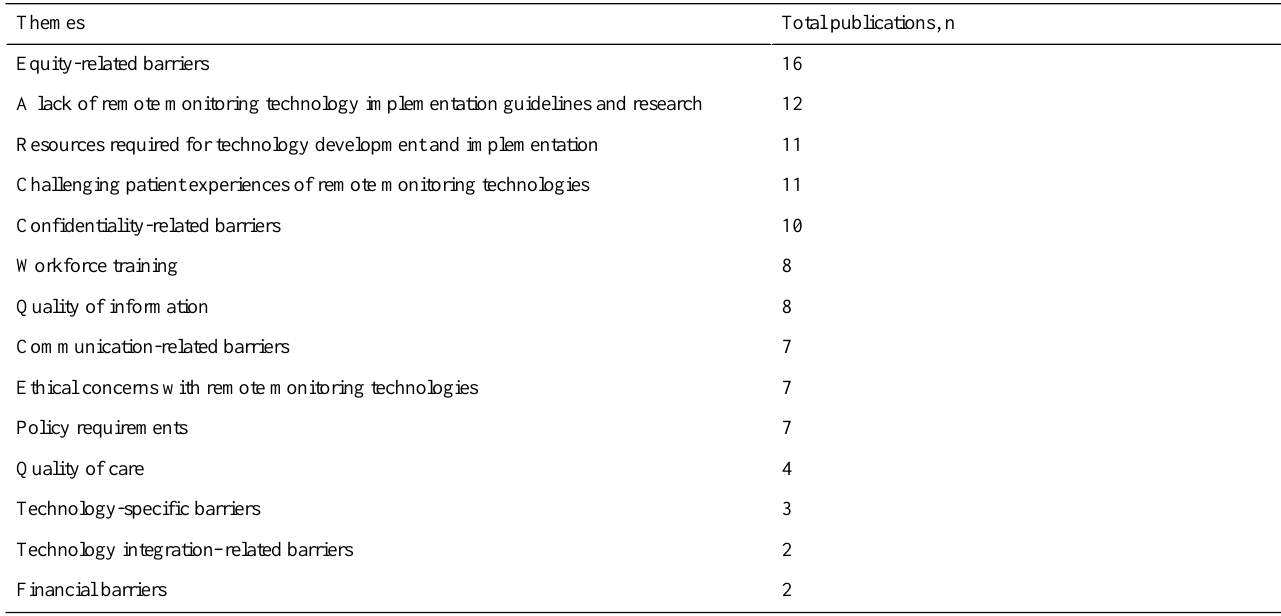
Table 4. Perceived barriers to using remote monitoring technologies for patients with COVID-19.